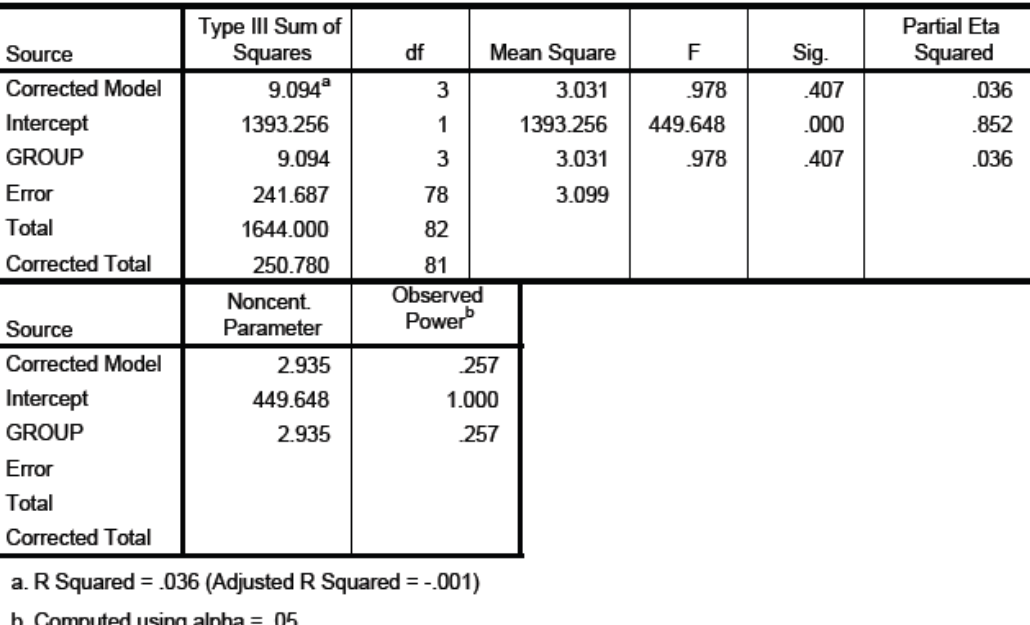
Figure B.13. ANOVA analysing enjoyment levels between the four groups of participants using raw